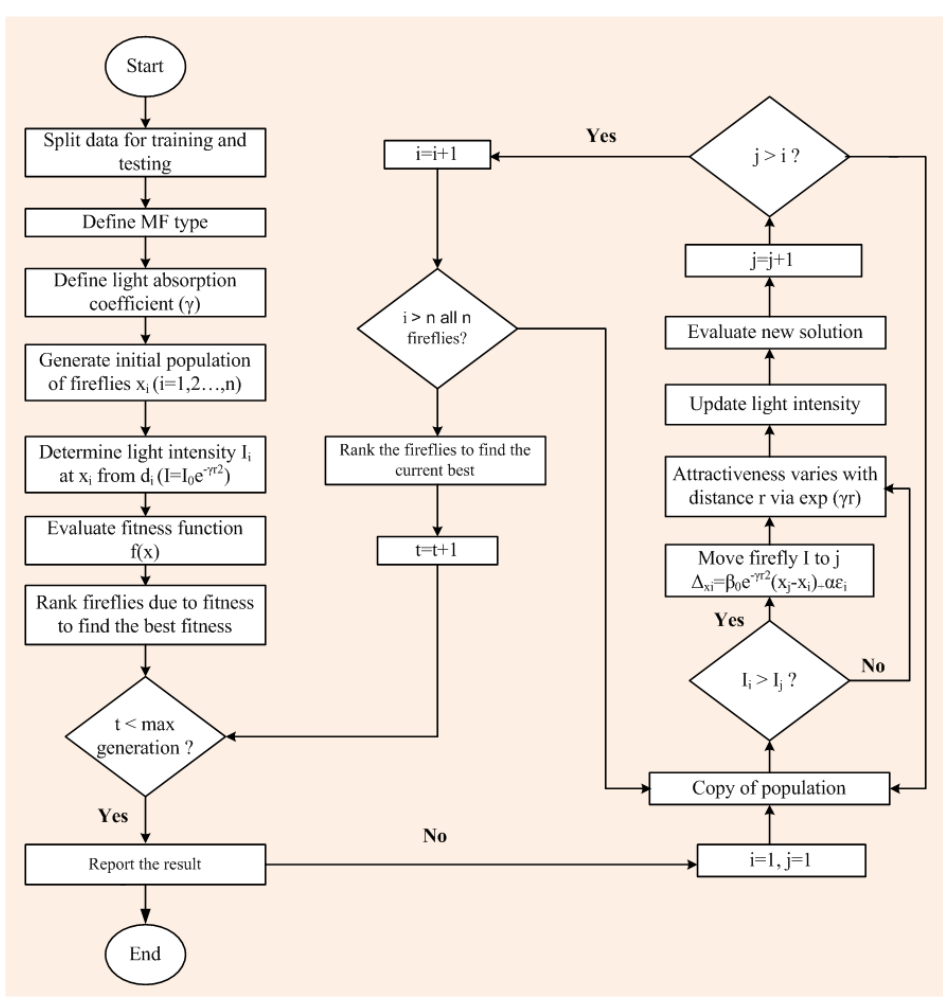
Figure 1. Flow chart of the ANFIS model.